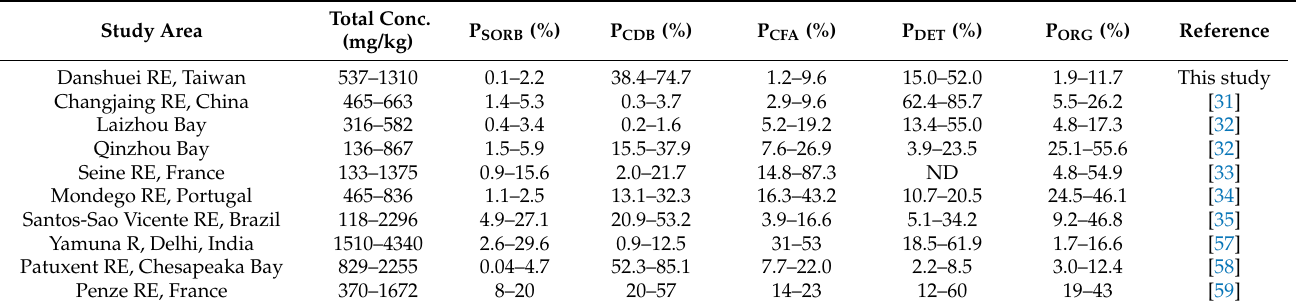
Table 5. Comparison the total concentrations range and percentage range of five sedimentary P species analyzed by the SEDEX method [26] obtained in the Danshuei River Estuary with the other eutrophic estuaries worldwide. Study